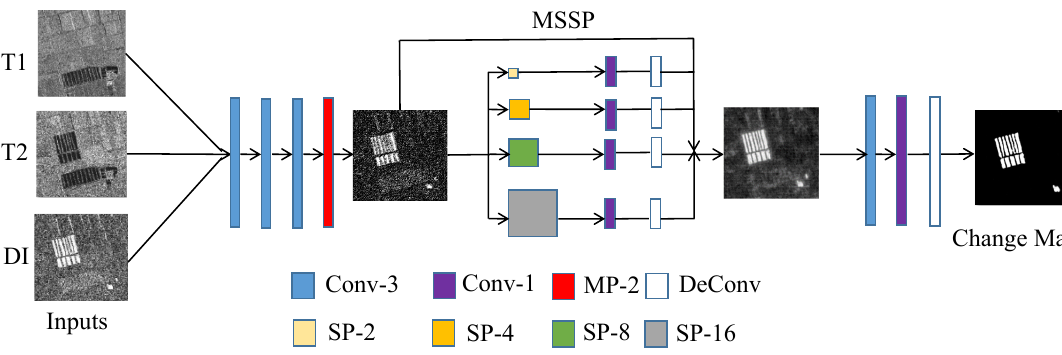
Figure 1. The illustration of the multi-scale spatial pooling (MSSP)-net. Table 1. The architecture of